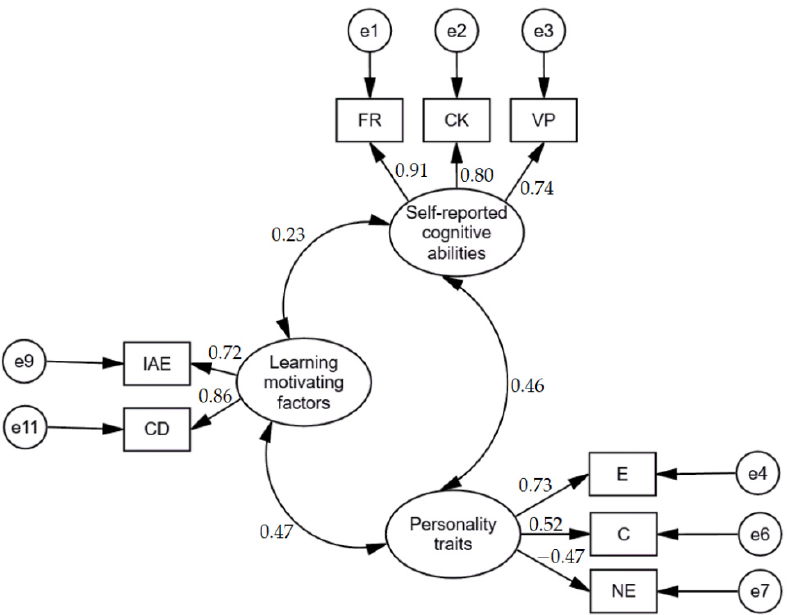
Figure 2. Standardized results of model on associations between learning motivating factors, self-reported cognitive abilities, and personality traits in group of non-participants of computer programming e-learning based courses. IAE: individual attitude and expectation; CD: clear direction; E: extraversion; C: conscientiousness; NE: negative emotionality; FR: fluid reasoning; CK: Comprehension-Knowledge; VP: visual processing.